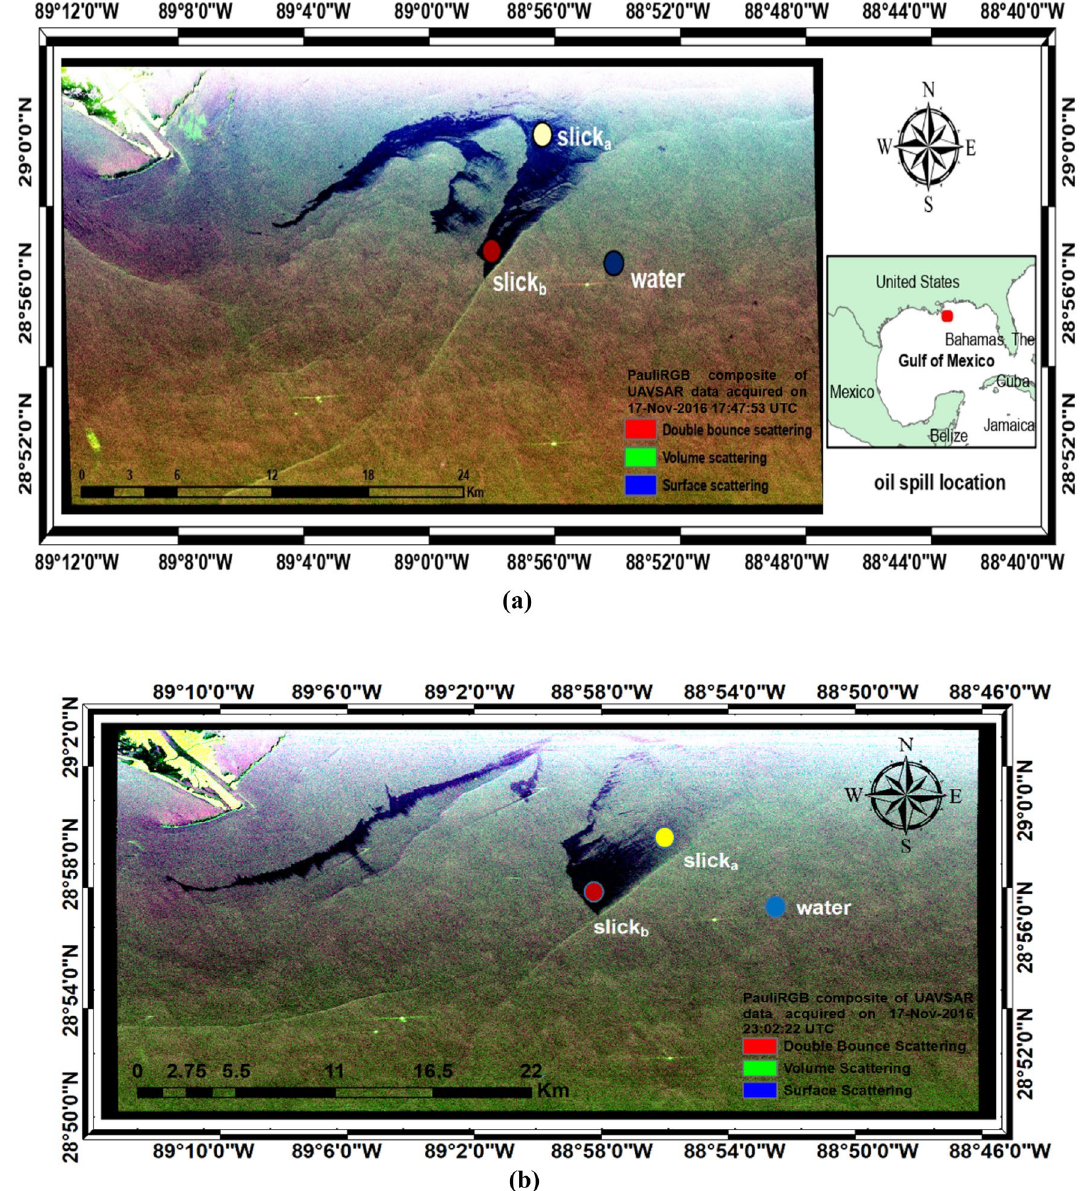
Figure 2. ( a ) Pauli RGB representation of DATA1 and the oil spill location (Gulf of Mexico), ( b ) Pauli RGB representation of the DATA2 (Gulf of Mexico) * . * Maps were created using ArcMap software by Esri. Please visit www. esri. com or https:// suppo rt. esri. com/ en/ produ cts/ deskt op/ arcgis- deskt op/ arcmap/ 10-6.